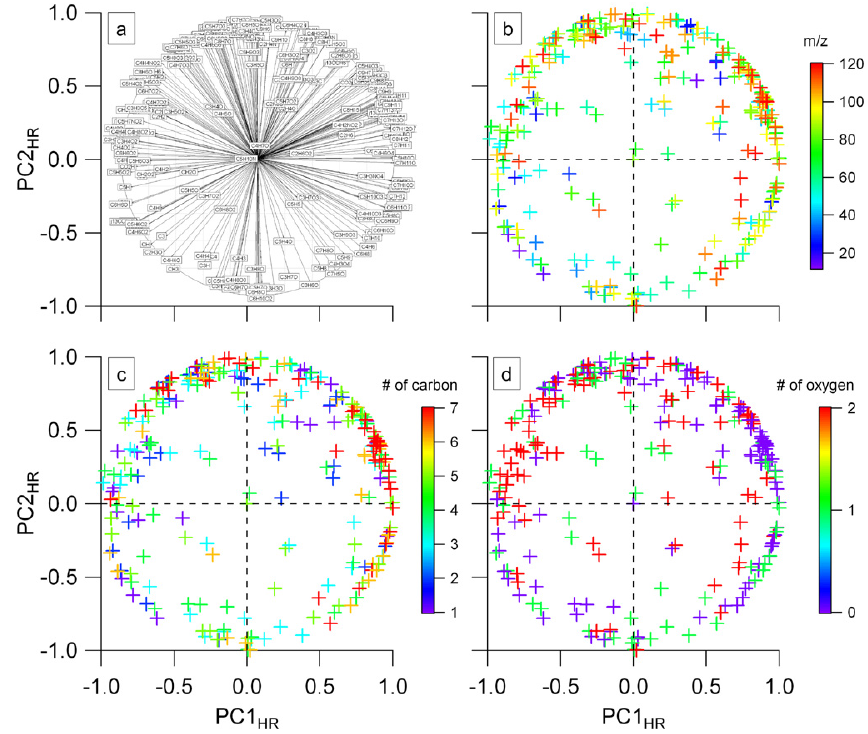
Fig. 9. Loading plots (PC2 vs. PC1) of the HR PCA model. The first panel shows the 337 ions that were fit in the m/z range 12–120 (see the supplementary information for a larger version). Panel b, c and d show the loading plot colored by the mass of the ions, the number of carbon atoms and the number of oxygen atoms